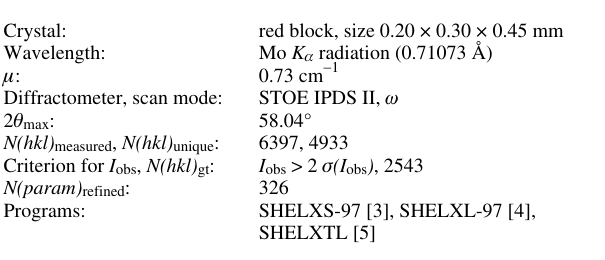
Table 1. Data collection and handling.